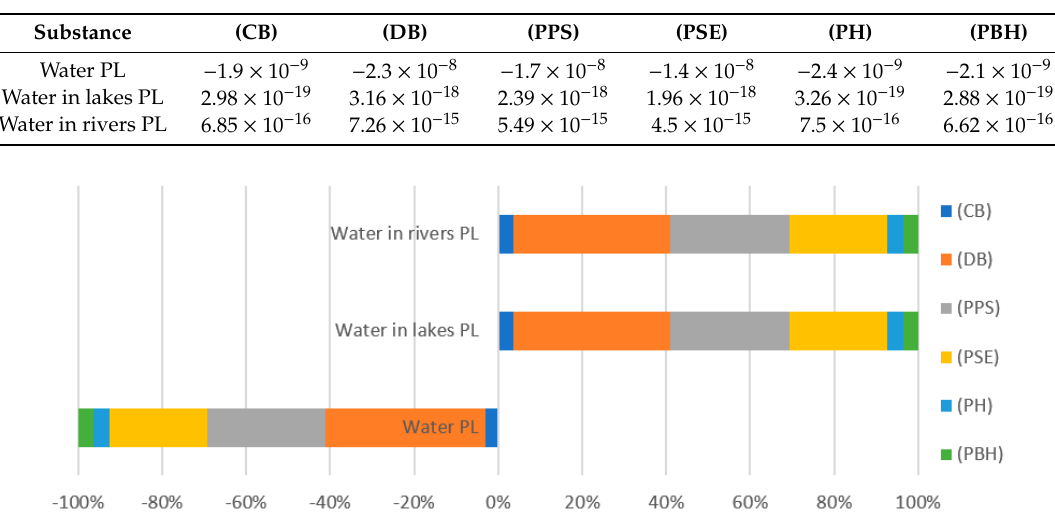
Table 7. Results of environmental impact characterization for the category of use of water resources (DALY).